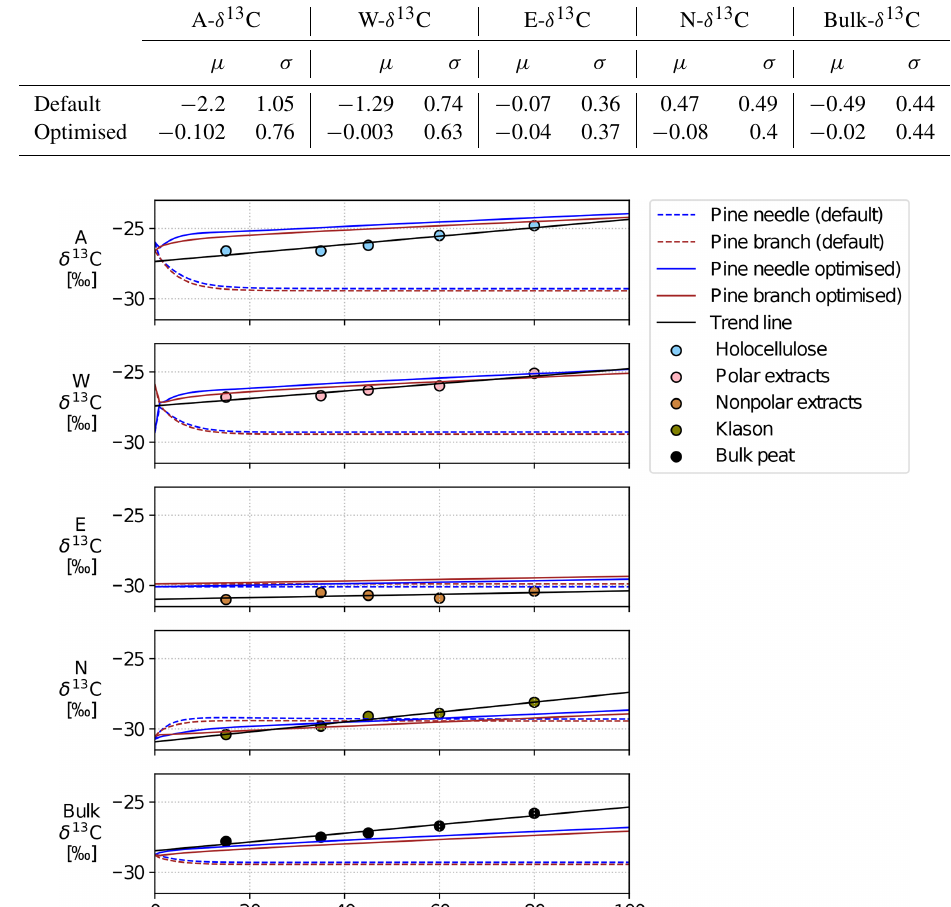
Table 2. Calculated default and optimised model bias (model − observations) mean and standard deviation for the different AWEN pools.